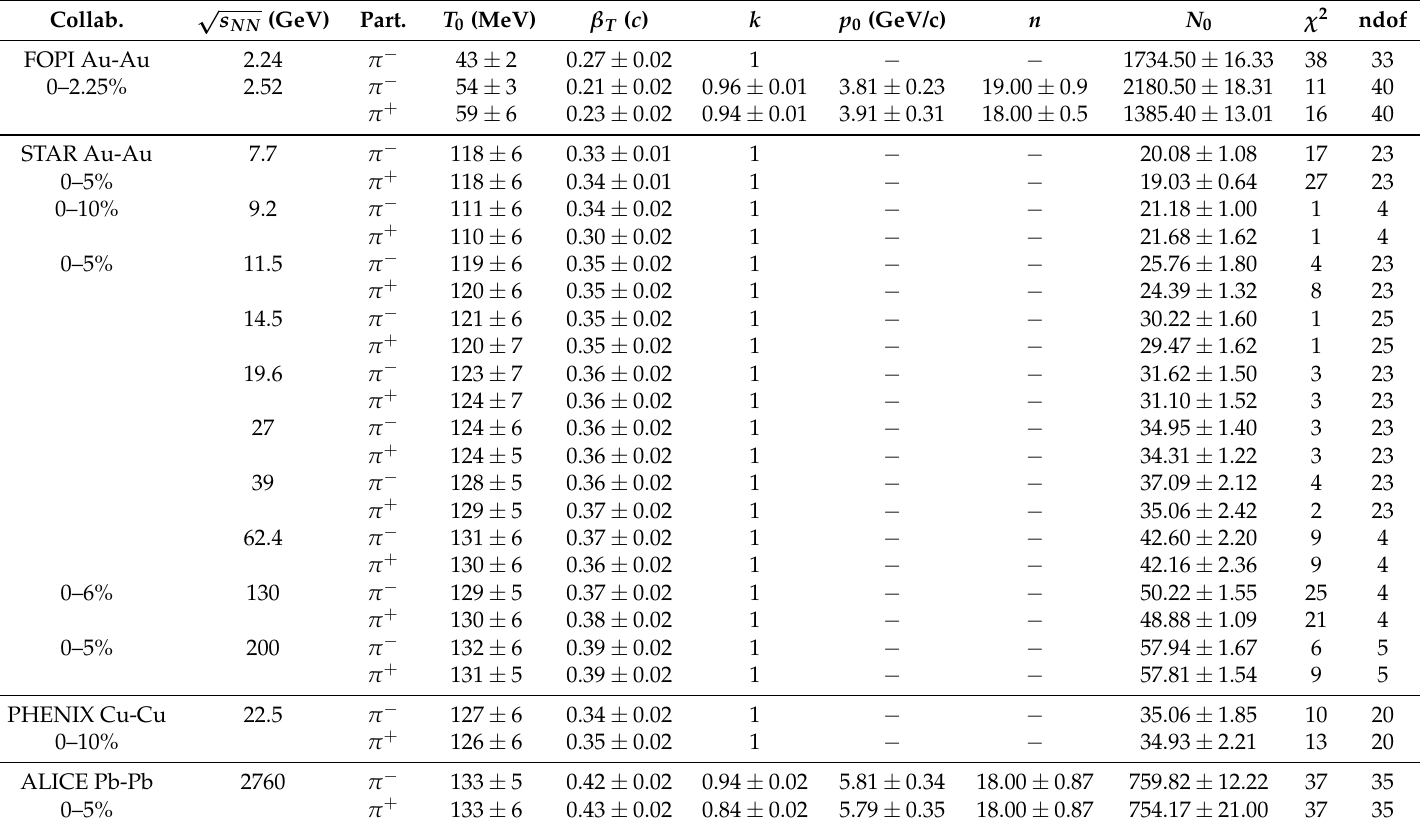
Table A1. Values of T 0 , β T , k , p 0 , n , N 0 , χ 2 , and ndof corresponding to the solid (dotted) curves for π − ( π + ) spectra in Figure